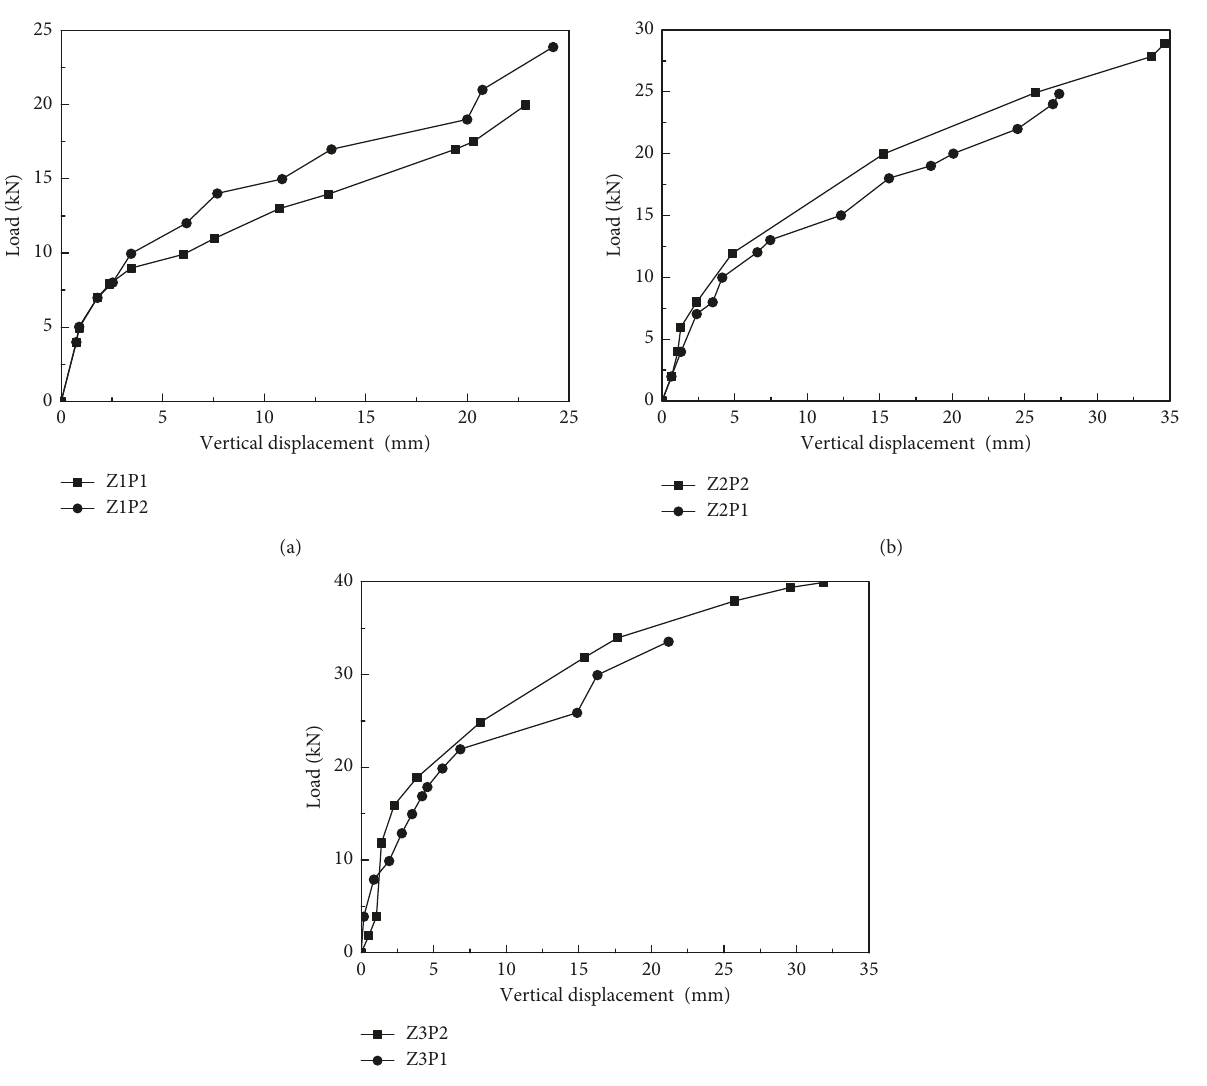
Figure 17: Relationship of vertical displacement and load of three depths of rock-socketed columns. (a) Rock-socketed depth is 300mm (P1: steel tube is 1mm; P2: steel tube is 0mm). (b) Rock-socketed depth is 400mm. (c) Rock-socketed depth is